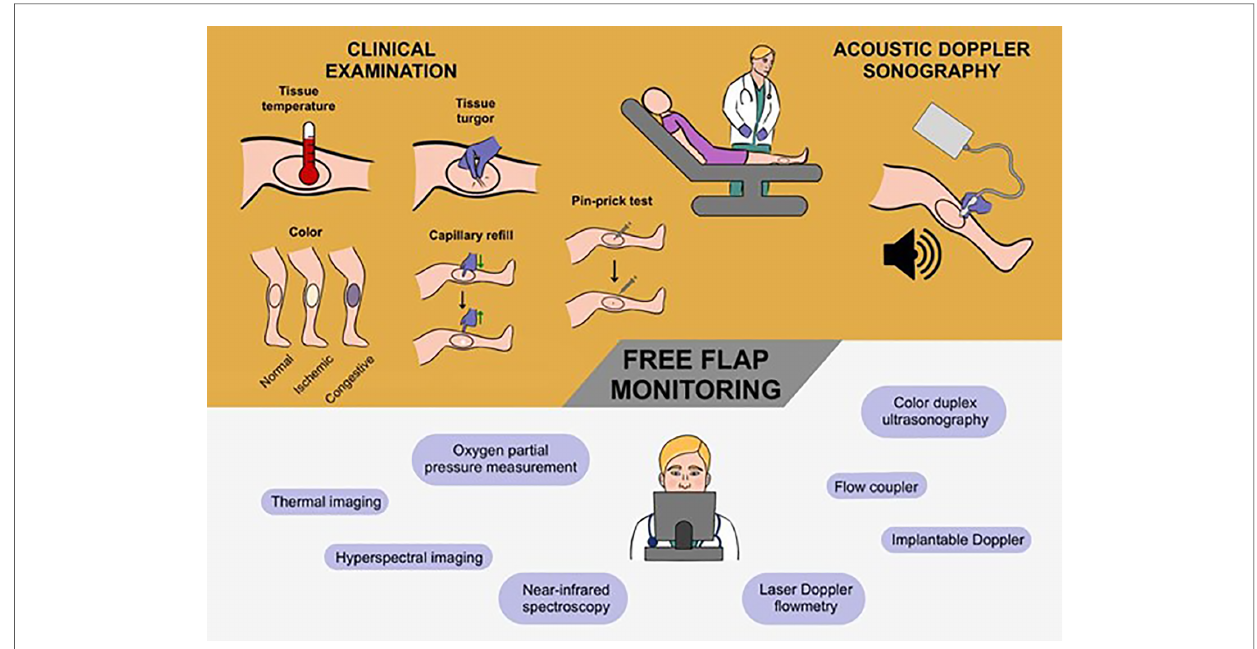
FIGURE 2 The current gold standard and novel techniques in the postoperative monitoring of free fl aps. To date, the combination of clinical examination and acoustic Doppler sonography is still considered the state of art to monitor free fl aps. More speci fi cally, the attending physician examines the free fl ap serially evaluating the fl ap temperature, turgor, color, and capillary re fi ll. Typically, this cornerstone of free fl ap assessment is supported by acoustic Doppler sonography as an instrument to sound the blood fl ow and velocity. Accordingly, the gold standard is based on a hands-on approach